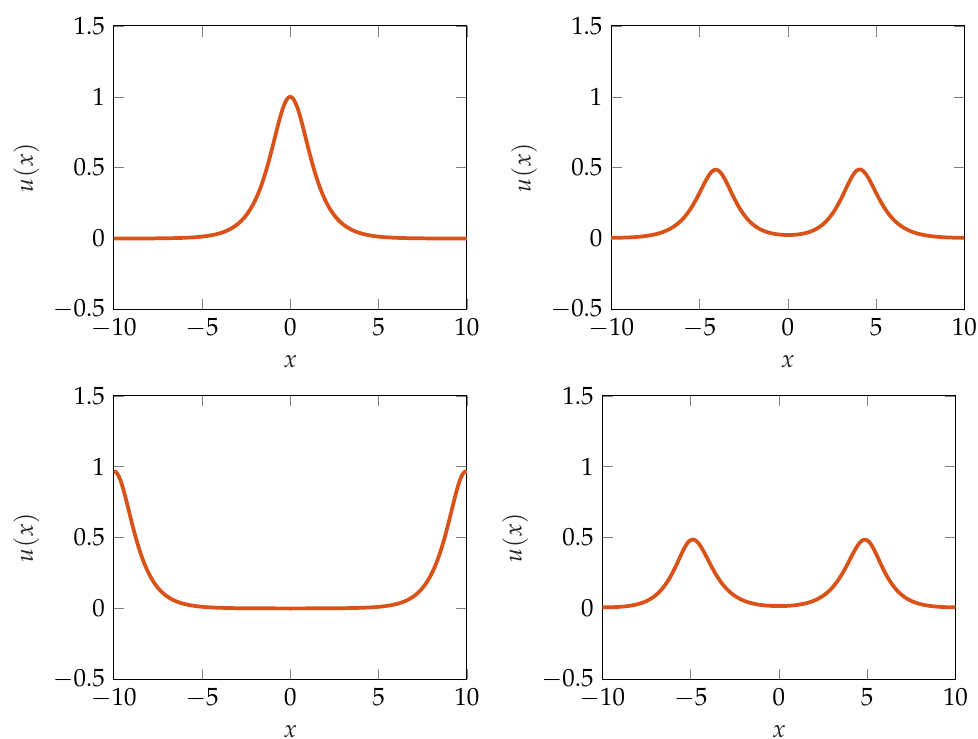
Figure 5. Evolution of waveforms for the non-linear seismic wave equation for t = 0, t = 4, t = 10 and t = 15.